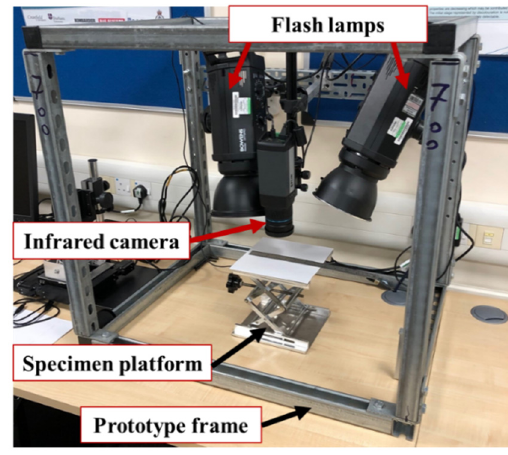
Figure 6. Experimental testing unit.